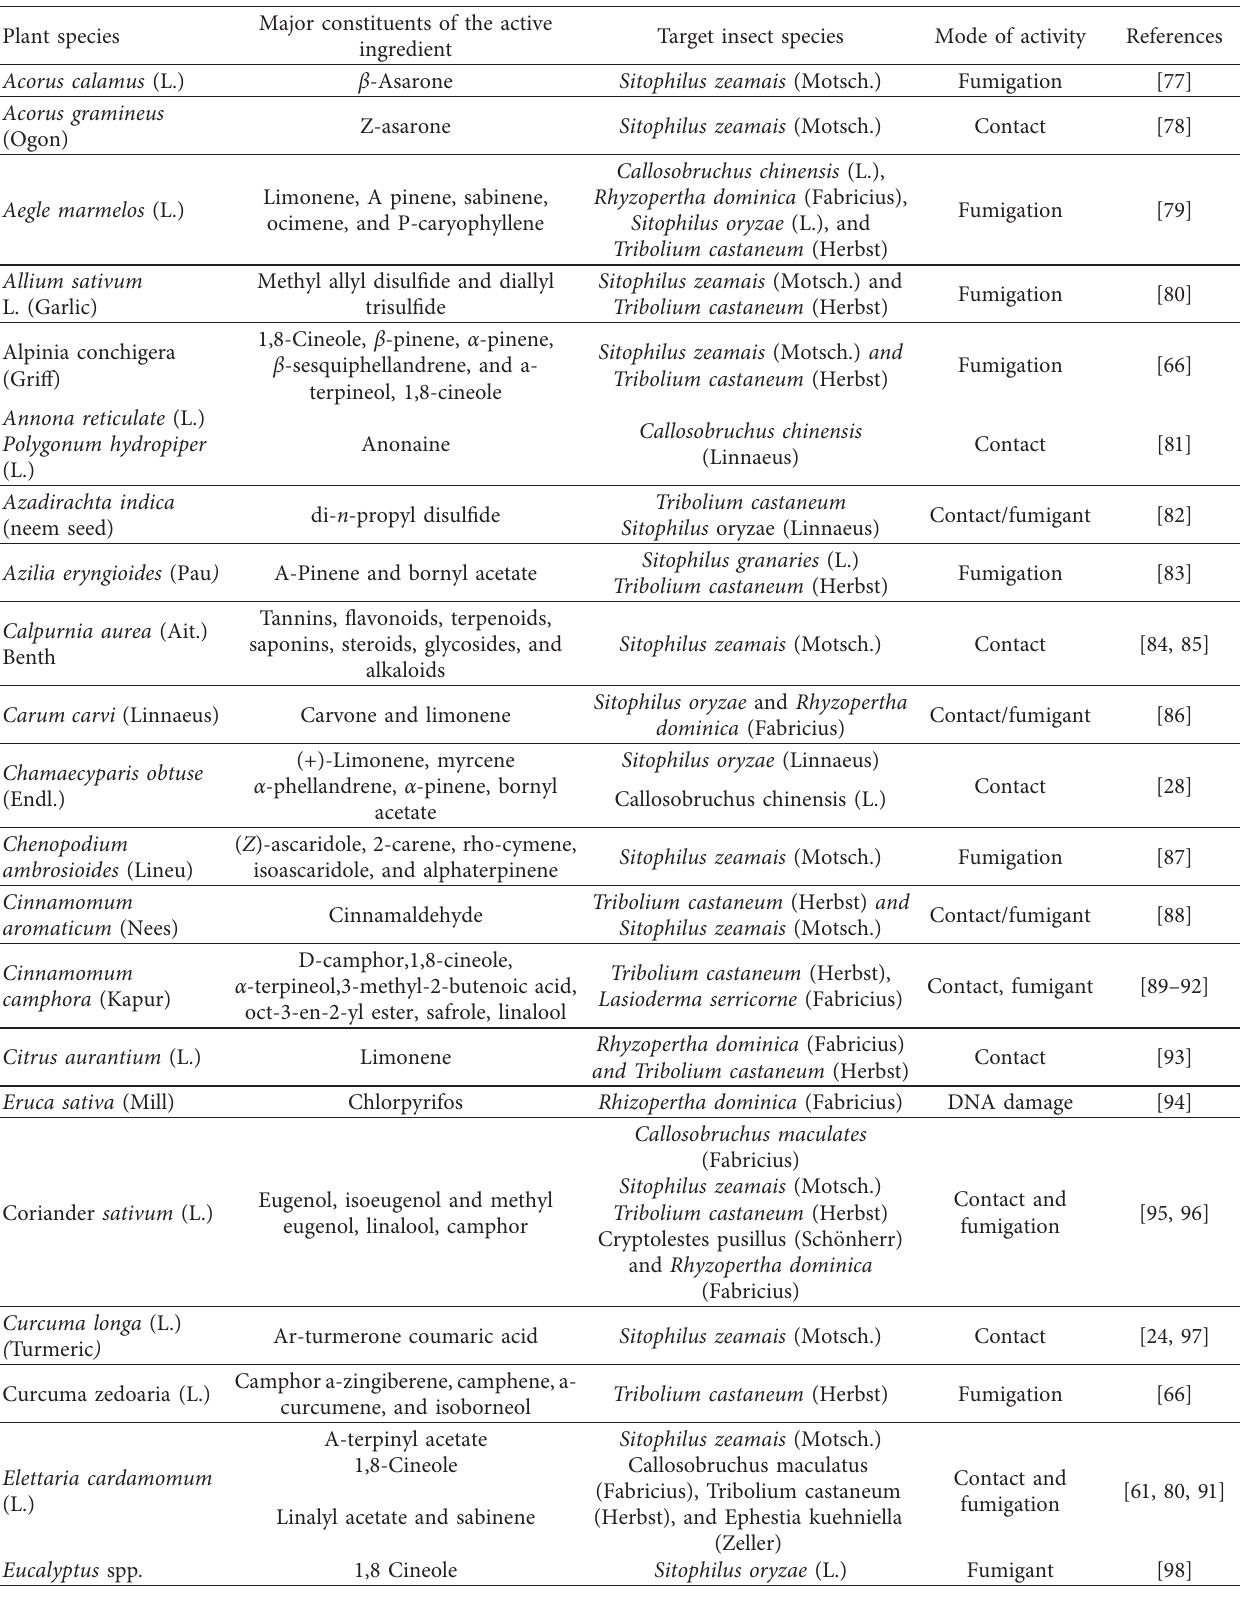
Table 3: List of some plant species with insecticidal property and their mode of